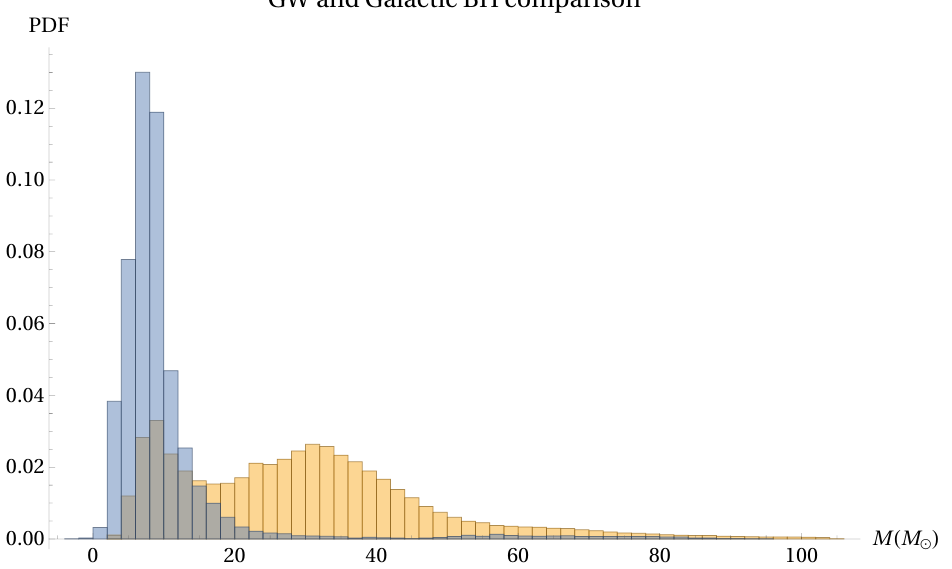
Figure 10. Comparison between the same mass draw from Galactic BHs shown in Figure 8 (blue histogram) and a mass draw from the extragalactic BHs from GWTC-3 (yellow histogram). We note the alignment between the Galactic peak and the lower extragalactic peak.